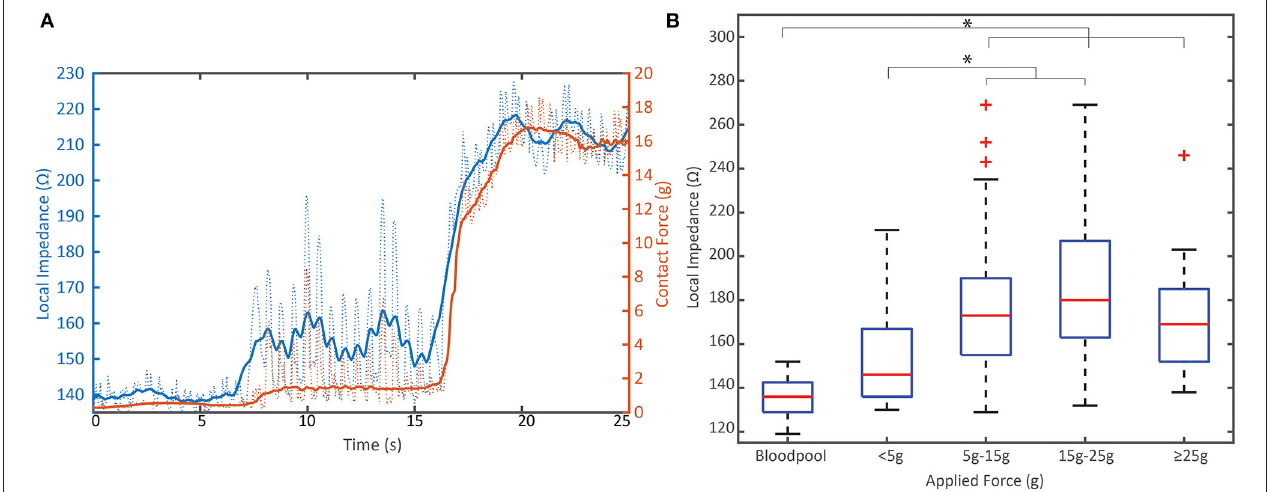
FIGURE 3 | Relationship between mechanical load and electrical load prior to RF. (A) Representative example of the dynamic change in local impedance with increasing mechanical coupling between the tissue and tip electrode. Solid lines represent average force or local impedance; dashed lines represent raw traces measured at 20Hz. (B) Distribution of the starting local impedance of all PVI RF applications by applied contact force compared to the local impedance in blood pool from N = 8 animals. Local impedance against tissue when > 5g is applied is significantly different than blood pool measurements ( p < 0.001). Data displayed in box and whisker plot where box represents 25th to 75th percentile, Red line is the median, dashed lines represent the minimum and maximum and the red crosses are outliers defined as a value that is more than 1.5 times the interquartile range away from the bottom or top of the box. ∗ indicates statistical